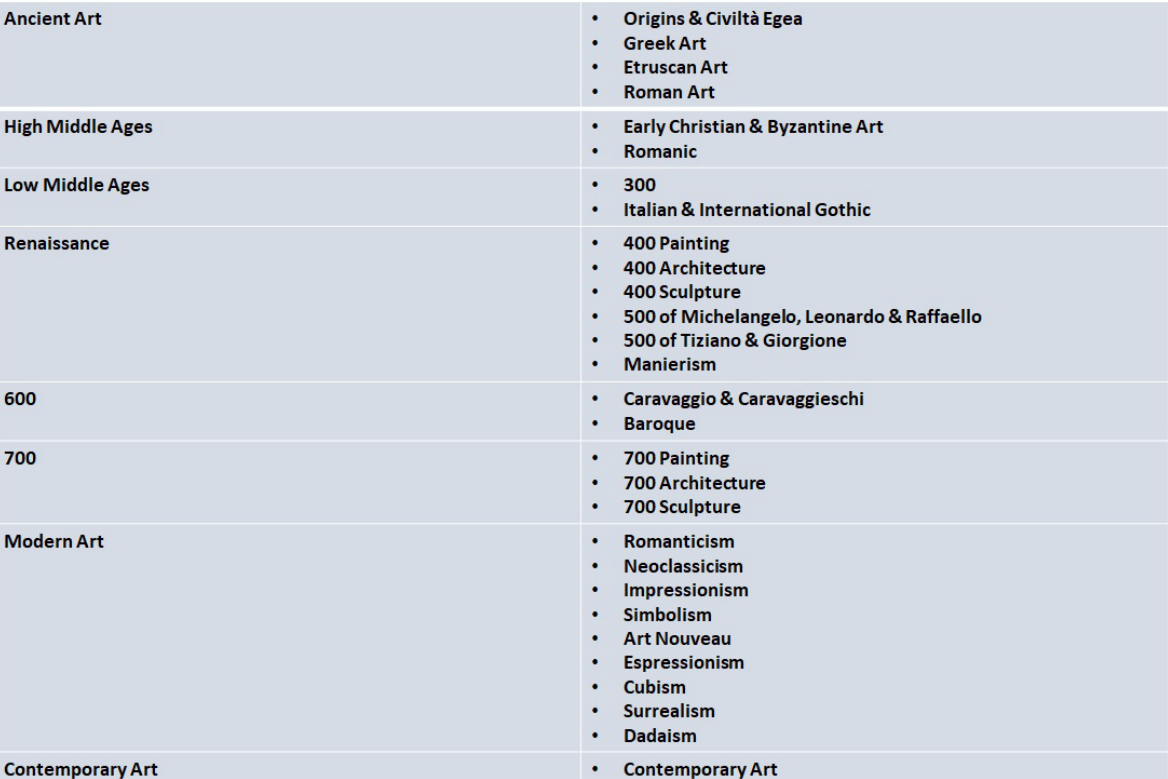
Figure 5. Example of artwork. On the left is a copy of the artwork, the right part contains the artwork’s data sheet. If the level of accuracy is high, the user can read, in addition to basic information such as title, author, time, technique, place, a more detailed description. The description can be read by the robot (by clicking on HERE button), as well as by the user. If the level is low, the bottom description is excluded. (Image credits : Galleria Borghese/photo Luciano Romano).